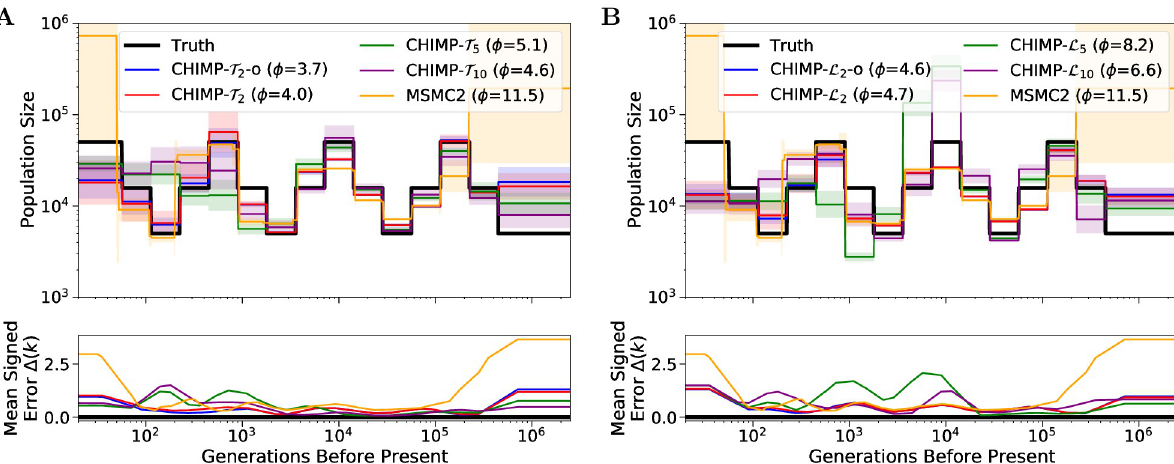
Fig 5. Results of inference in the piecewise sawtooth scenario from a sample of size n = 10 for different subset sizes using either T MRCA (Panel A) or L (Panel B) as the hidden state. We infer the population sizes in the intervals, fixing the change points to match the truth (shown in black). For CHIMP , we use non-overlapping subsets of sizes n s = 2, 5, and 10. For n s = 2, we also present overlapping subsets (-o). We present results obtained using MSMC2 for comparison. Solid lines are averages over 16 replicates and the standard deviation is indicated by the shaded areas. Mean signed error Δ ( k ) is shown in bottom plot and has been smoothed using moving average for visualization purposes. The integral ϕ is indicated in the legend. Note that MSMC2 groups epochs in the very distant past due to limits of the method interface.